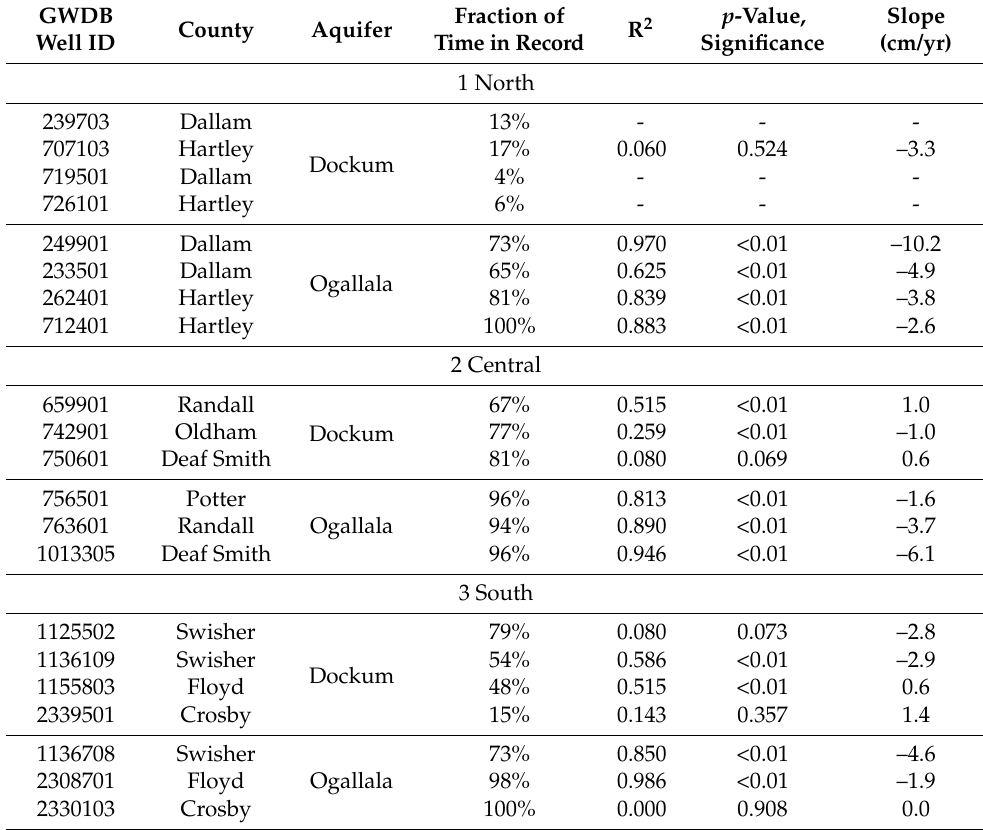
Figure 6. Selected water level trends from 1970 to 2020 in the Dockum and Ogallala Aquifers in the study area. Wells from each spatial group were selected according to the longest continuous measurement record. All well IDs are Texas Water Development Board IDs used in the GWDB. Table 2. Water level trend linear regression summary examining all years in the GWDB records from 1970 to 2021 (51 years). All trends were determined the at p = 0.01 threshold.